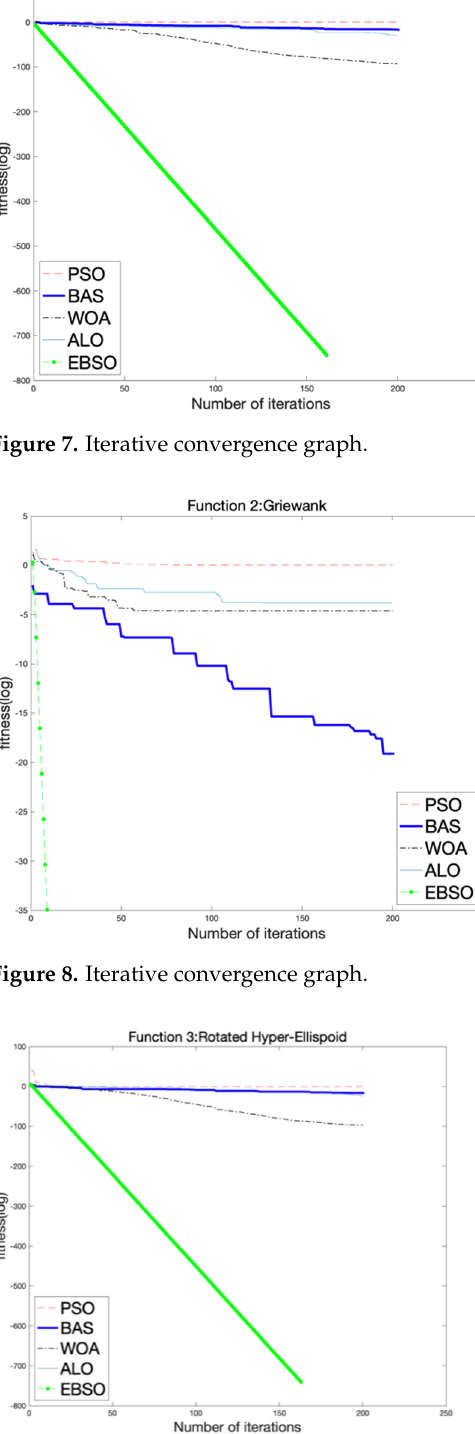
Figure 10. Iterative convergence graph. Figure 11. Iterative convergence graph.